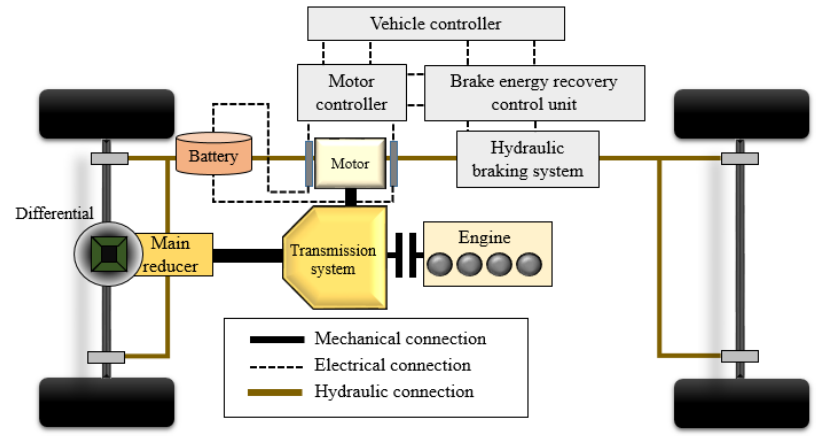
Figure 1. Schematic diagram of Hybrid Electric Vehicle.